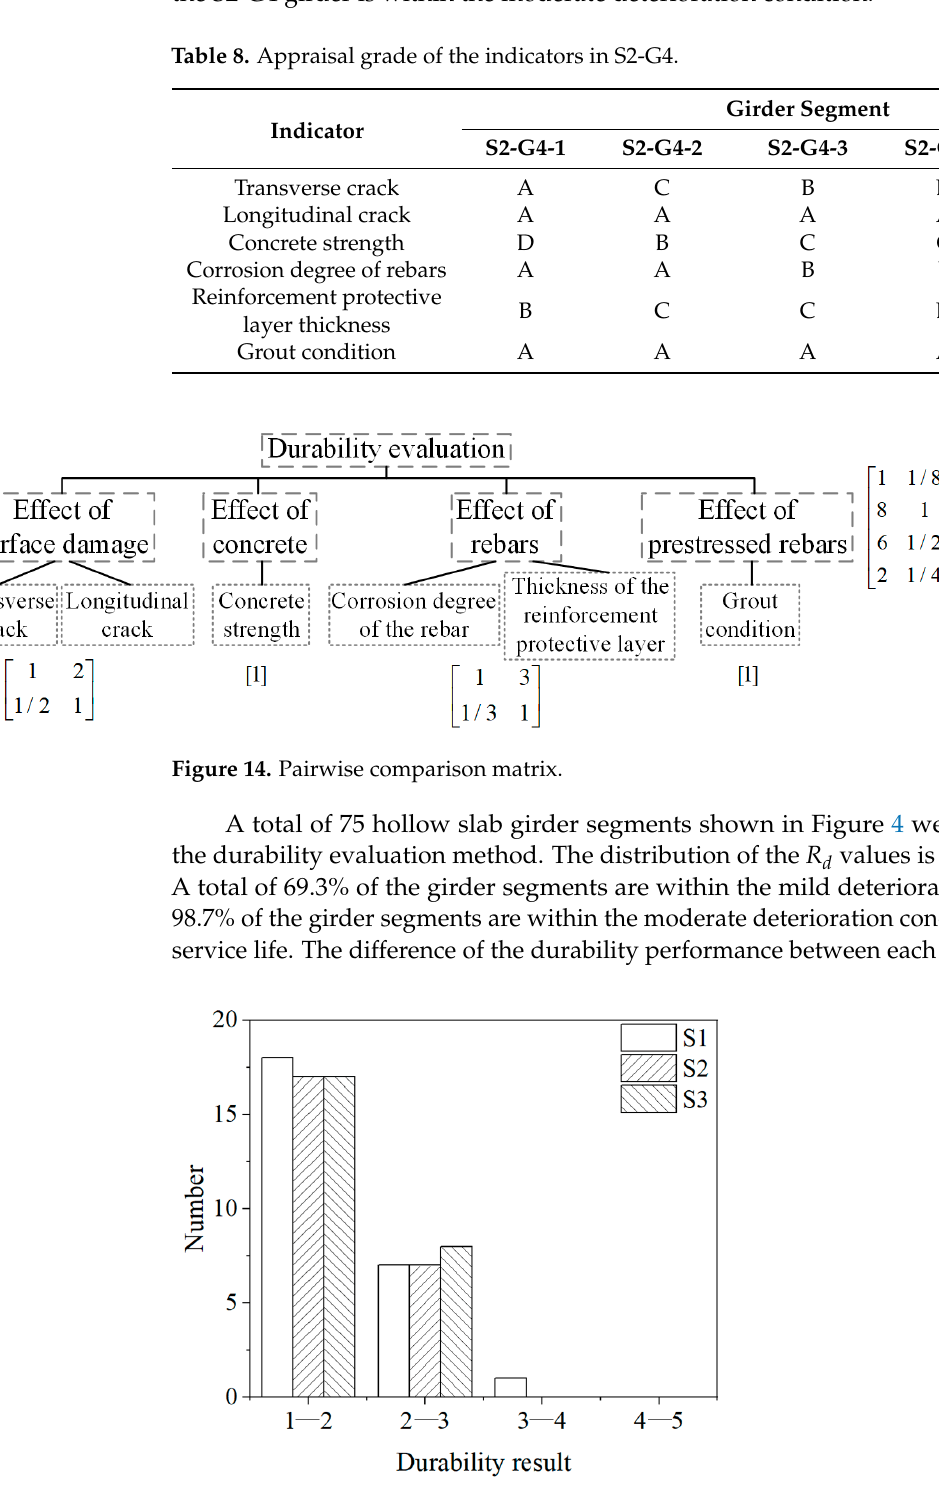
Figure 15. Durability of the hollow slab girder